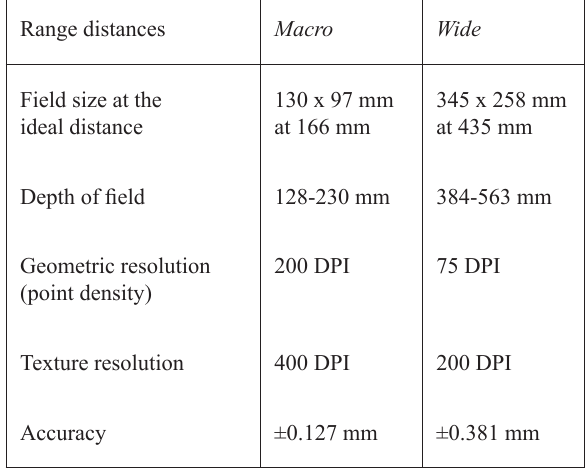
Table 3. Technical speci fi cations of NextEngine